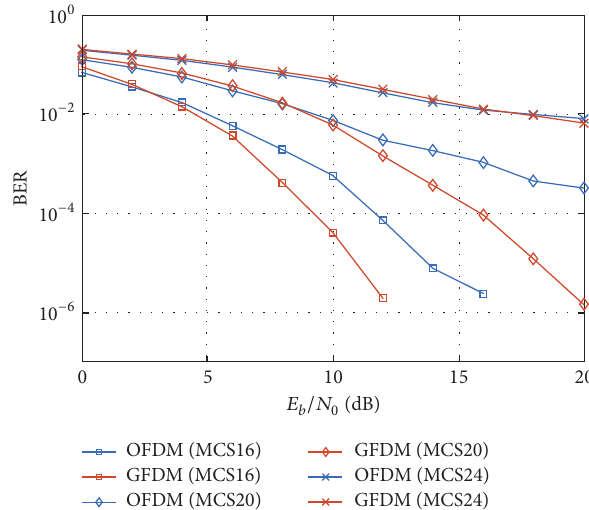
Figure 14: BER comparison between OFDM and GFDM (MCS 16, 20, and 24, 𝛼 = 0.1 ,